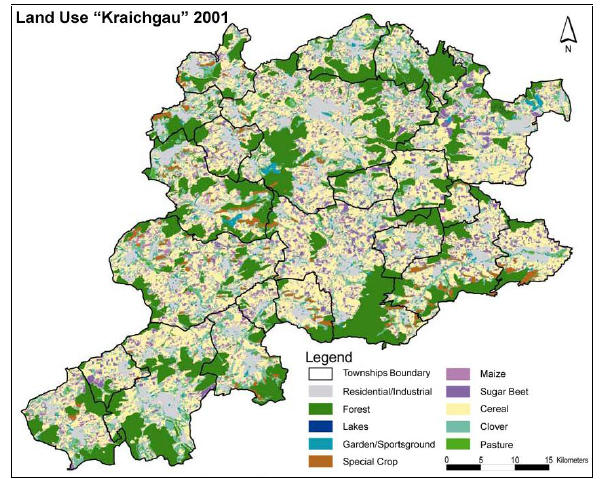
Figure 4. Crop type map for the “Kraichgau” (Rohierse, 2004)